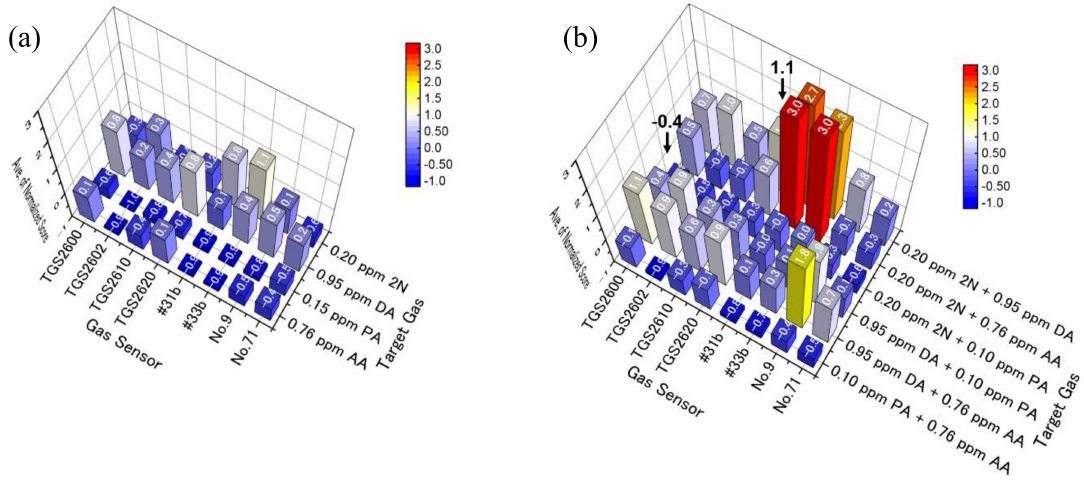
Figure 6. Average normalized scores of eight sensors to ( a ) one and ( b ) two target gases without contaminant gases.